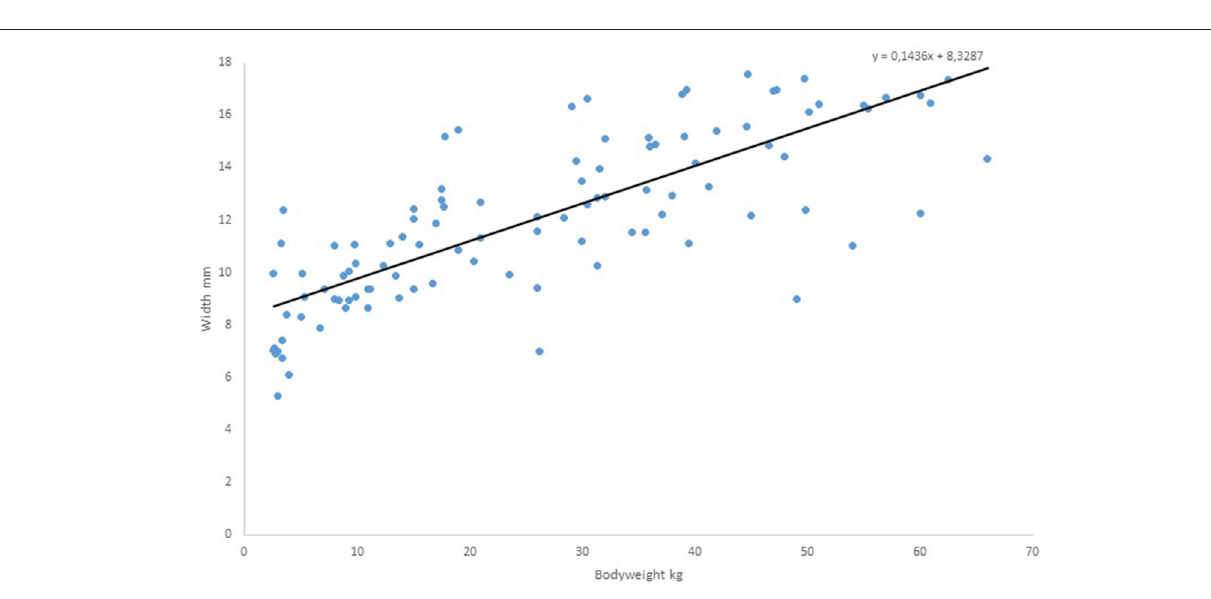
averaged values were then available per patient, in each case a.p. and laterally at the upper and lower measuring point. Then, the mean values were calculated from the a.p. and lateral measurements at both sites to obtain the mean diameter at each site. The values obtained were statistically evaluated and formed the basis for the curves and the